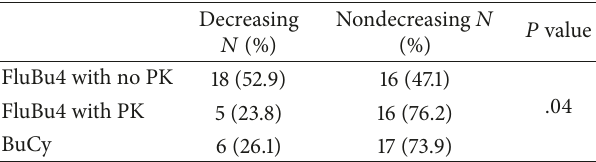
Figure 1: Boxplot for day 30 and day 100 chimerism for each of the 3 conditioning regimens. Bu, busulfan; Cy, cyclophosphamide; Flu, fludarabine; PK, pharmacokinetics; SCT, stem cell transplant. Table 4: Decreasing and nondecreasing total chimerism between day 30 and day 100.